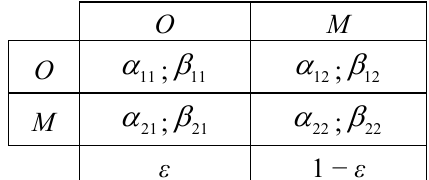
Table 2. SG matrix, Optimization Stability Analysis